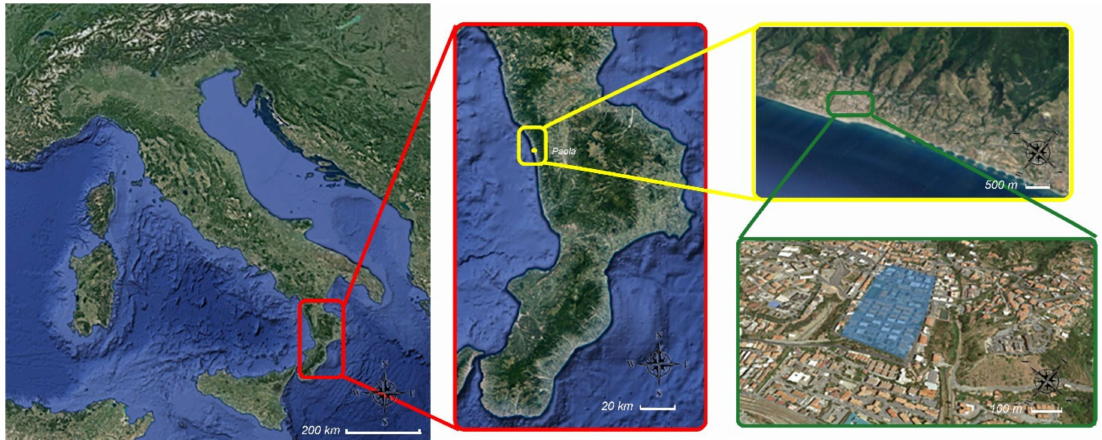
Figure 2. Case study location. A map of Italy with Calabria Region ( left ), the location of Paola village in Calabria Region ( middle ), and a zoom-in of Paola (in yellow box) and of the specific highly urbanized area considered as a case study (in green box) ( right